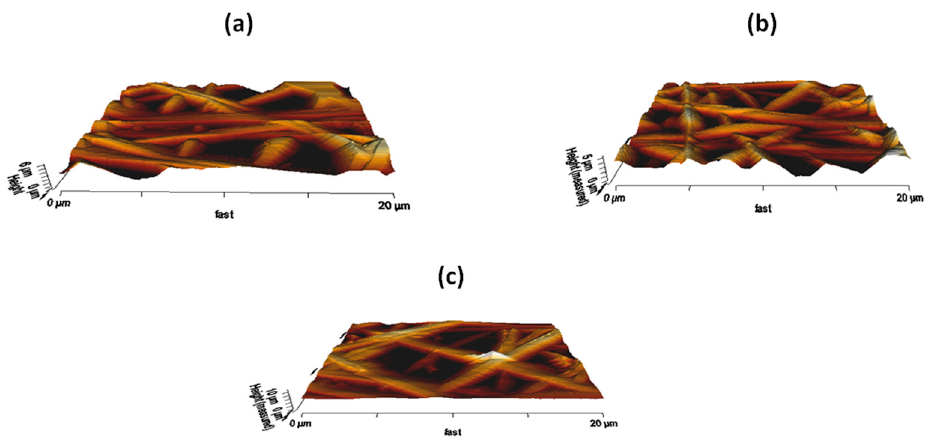
Figure 10. AFM images of ( a ) PU, ( b ) PU/BASIL and ( c ) PU/BASIL/TiO 2 .